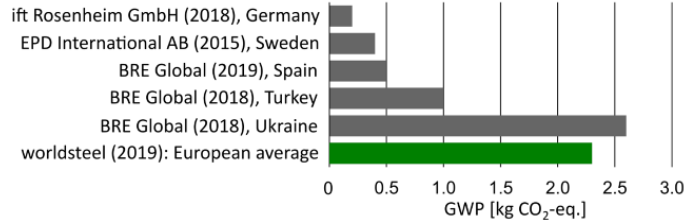
Figure 1. Comparison of GWP values extracted from EPDs with the European average of